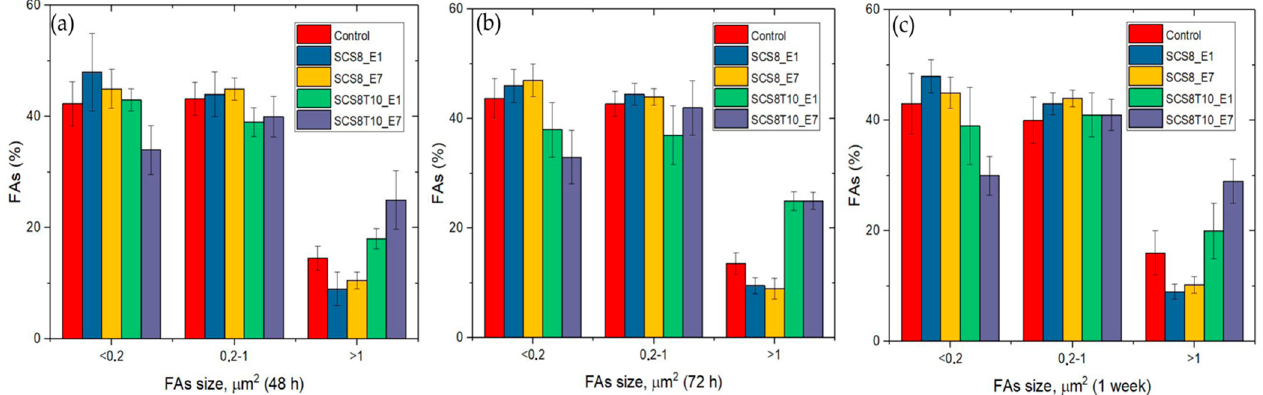
Figure 10. Time-dependent percentage of FAs according to size imaged in HOB ® cells grown on the described xerogels after ( a ) 48 h in culture, ( b ) 72 h in culture, ( c ) 1 week in culture. One-way analysis of variance. Statistical significance was defined as p < 0.05.